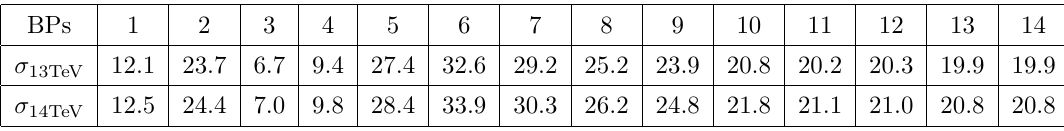
Table 7 . The significances for all 14 BPs at the LHC are tabulated, where the luminosity is √ assumed to be 300 fb − 1 at both s = 13 and 14